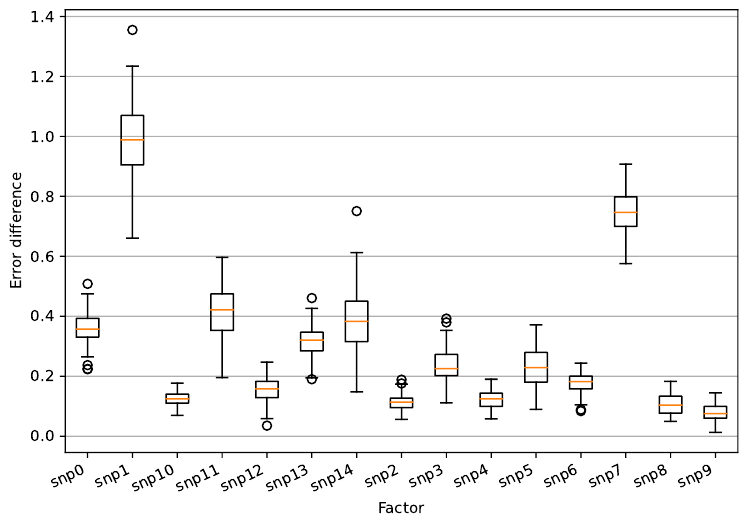
Figure 7. Impact of SNPs to the model solution calculated by permutation test. The boxplots show the difference in root mean squared score in respect to days from planting to flowering.